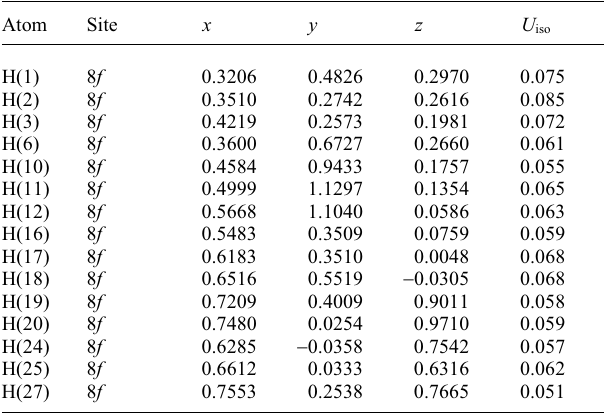
Table 2. Atomic coordinates and displacement parameters (in Å 2 )